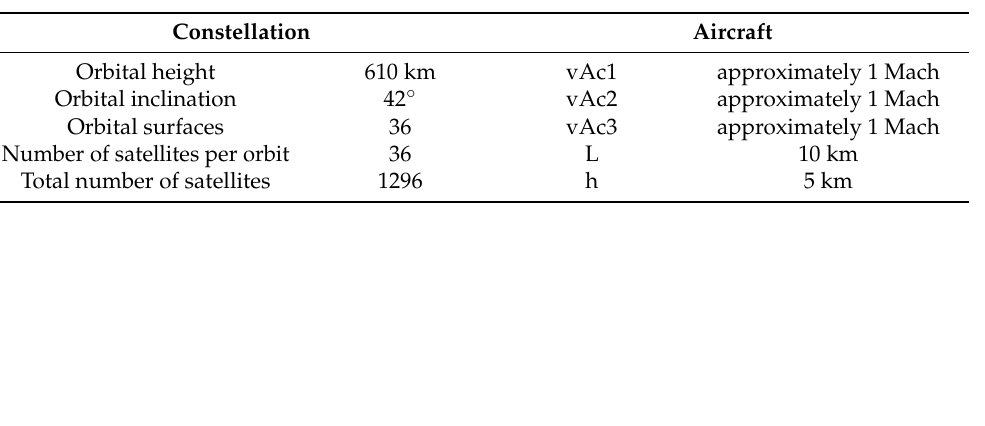
Table 1. Main parameters of the Kuiper constellation and